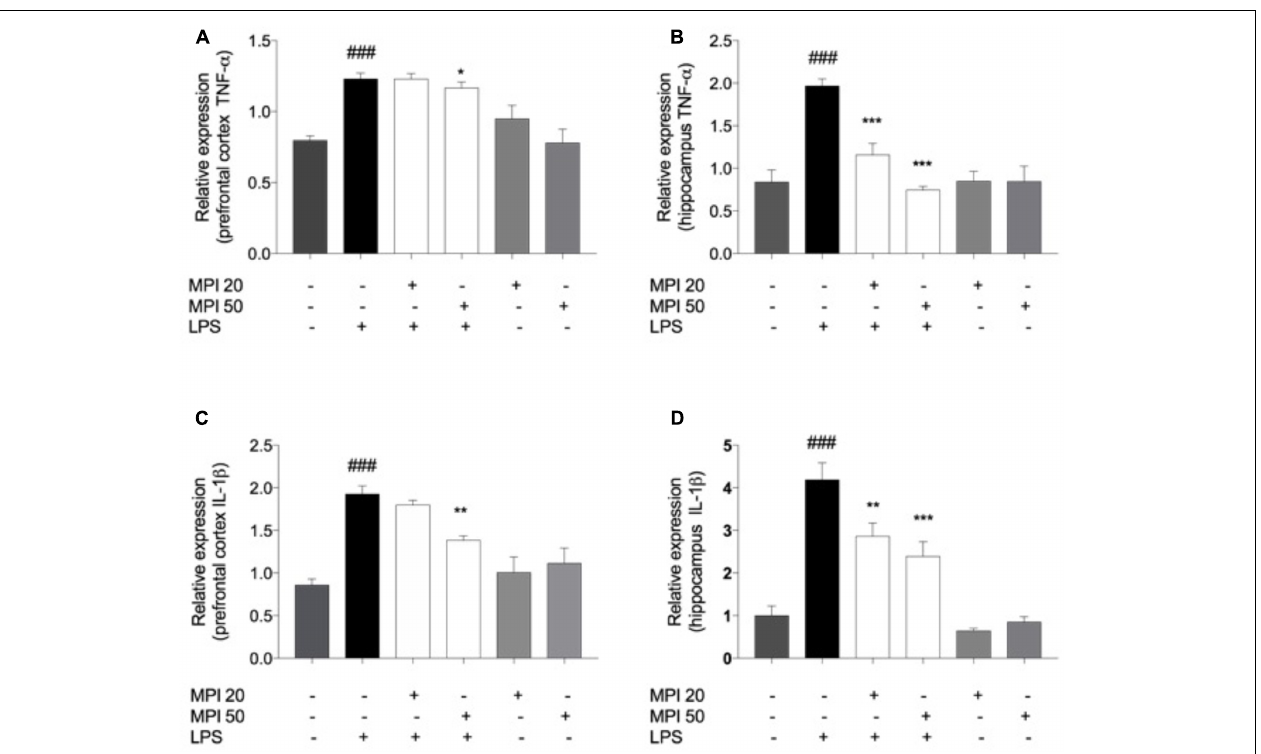
FIGURE 6 | TNF- α levels in (A) PFC and (B) HC and IL-1 β in PFC (C) and (D) HC of LPS-induced group mice increased significantly when compared to the control group ### P < 0.001. MPI followed by LPS administration prevented the increase of TNF- α levels in (A) PFC only in the 50 mg/kg dose ( F 5 , 30 = 10.06, P < 0.05 post hoc ∗ P < 0.05, n = 6) ( ∗ ) and in the both doses in (B) HC ( F 5 , 30 = 16.69, P < 0.001, post hoc ∗∗∗ P < 0.001, n = 6) ( ∗∗∗ ) when compared to the LPS-induced group. MPI followed by LPS administration prevented the increase of IL-1 β expression in (C) PFC only in the 50 mg/kg dose ( F 5 , 30 = 13.21, P < 0.05 post hoc ∗ P < 0.05, n = 6) ( ∗ ) and in the both doses in (D) HC ( F ∗∗∗ P < 0.001, ∗∗ P < 0.01, n = 6) ( ∗∗∗ )( ∗∗ ) when compared to the 5 , 30 = 23.63, P < 0.001, post hoc LPS-induced group. No significant differences observed among the control and MPI followed by saline admnistration. Data were analyzed using a one-way ANOVA followed by the Student–Newman–Keuls multiple comparisons post hoc test. Error bars represent